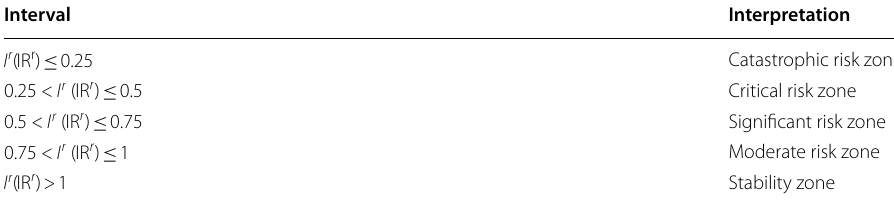
Table 2 Interpretation of indicators’ values by risk grade